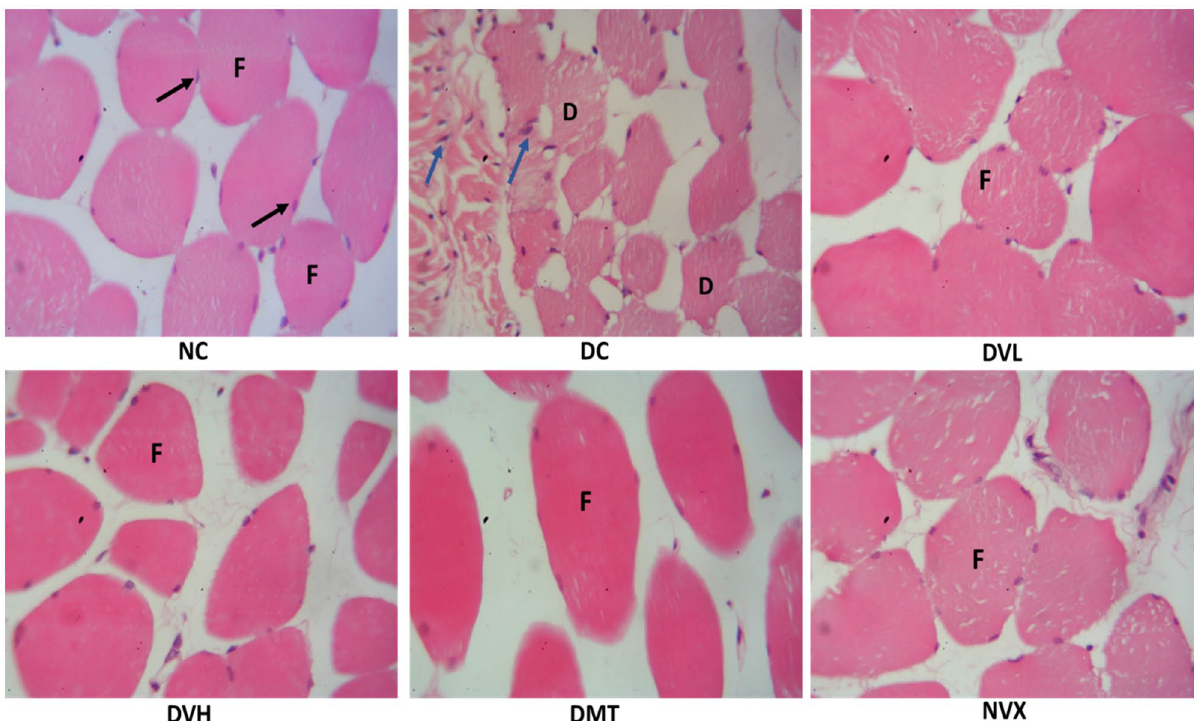
Figure 12. Histological changes in the muscles of experimental groups. magnification = × 400. f—muscle fascicles; d—degenerating muscle fibres; black arrows—myocyte nuclei; blue arrows—inflammatory infiltrate. NC = normal rats, DC = diabetic control, DVL = diabetic rats + vanillin (150 mg/kg b.w), DVH = diabetic rats + vanillin (300 mg/kg bw), DMT = diabetic rats + metformin (200 mg/kg b.w), and NVX = normal rats + vanillin (300 mg/kg bw).